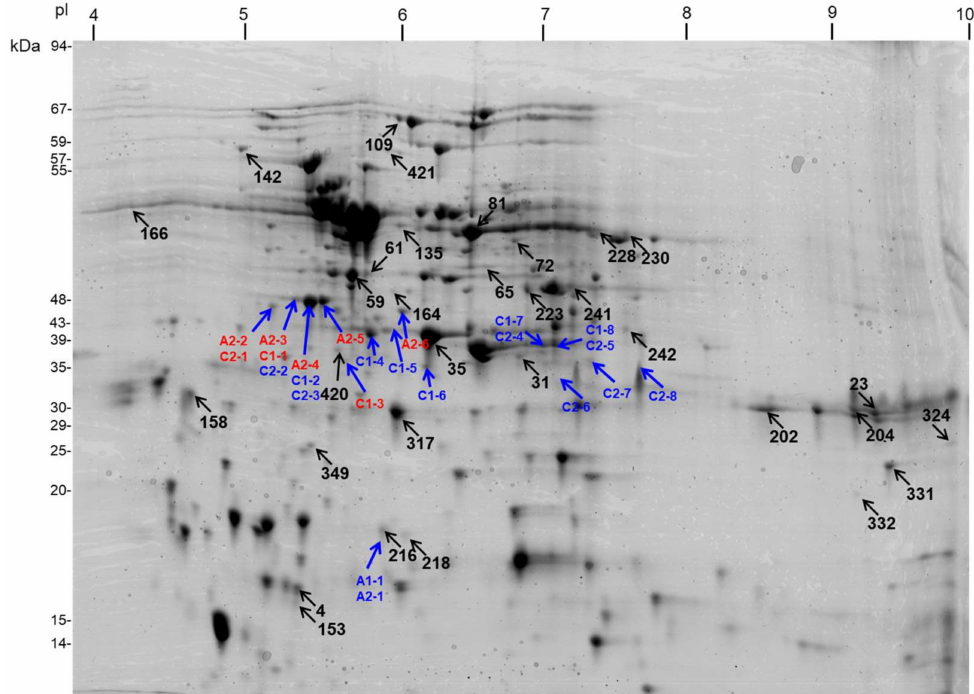
Figure 1. Position of 32 drought-responsive spots ( black arrows ) on Coomassie Brilliant Blue (CBB)-stained two–dimensional (2D) master gel with separated cauliflower mitochondrial proteins (proposed identities of all protein spots are shown in Table S1 and peptide data in Table S4). This map also shows positions of additional protein spots ( blue arrows ) from two-dimensional (2D) gels containing resolved mitochondrial proteins of “ Adelanto ” (A) and “ Casper ” (C), that were cut out and used for the identification of tryptic peptides specific to dehydrin-like proteins (proposed identities for those spots appear in Table S6). Identifiers for spots containing the mentioned peptides are marked in red (remaining labels— in blue ). For molecular mass calibration (kDa) of protein spots, PageRuler Prestained Protein Ladder (Thermo Scientific, Gda´nsk, Poland) and Low Molecular Weight (LMW)-SDS Marker Kit (GE Healthcare Poland, Warsaw, Poland) are used. For calibration of spot isoelectric point (pI), Broad pI Kit (GE Healthcare) is used. Further data found in the